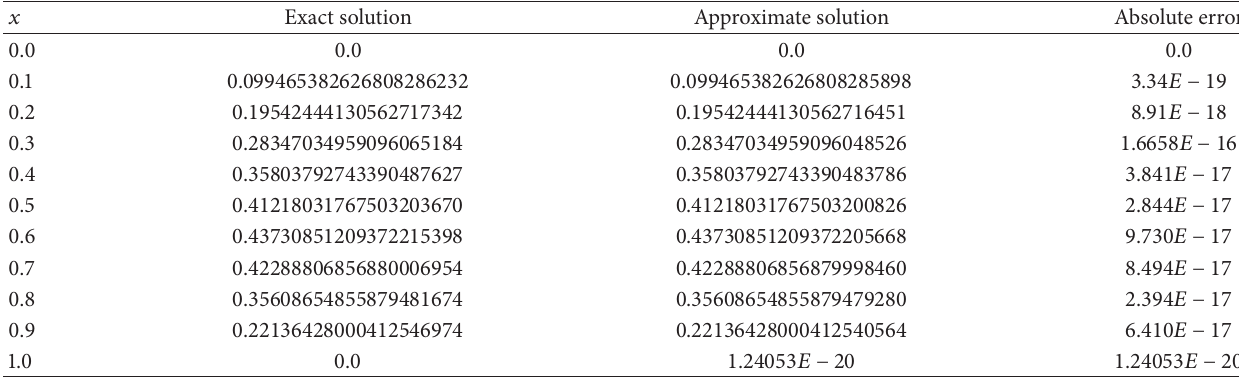
Table 3: Numerical results for Example 11 (time (s): 3.123).